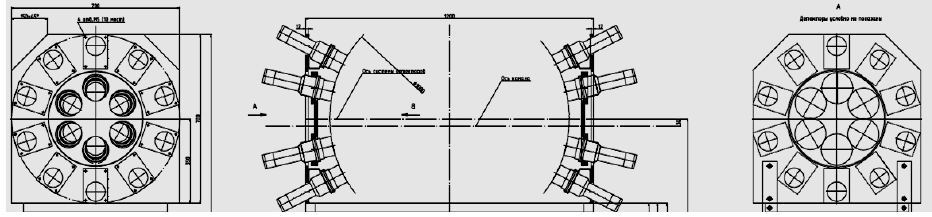
Fig. 5. Fast neutron detector composed of 32 liquid scintillation modules with position sensitive twin ionization chamber in centre (not shown in